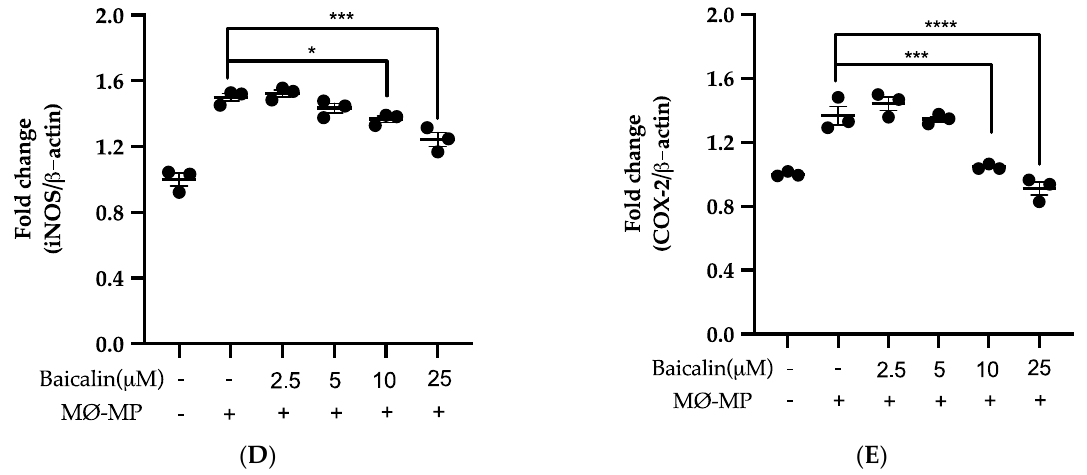
Figure 2. Effect of baicalin on nitric oxide (NO) production, iNOS, COX-2 protein expression in RAW 264.7 cell. ( A ) RAW264.7 cell was incubated with MØ-MP and a various dose of baicalin for 24 h, followed by MTT solution for 4 h. The absorbance of purple formazan was taken at 540 nm. ( B ) RAW264.7 cell was treated with or without MØ-MP and various doses of baicalin for 24 h. The NO release by activated RAW264.7 in the supernatant media was mixed with an equal volume of Griess reagent and absorbance of resultant color was taken at 540 nm. ( C ) The cell lysate of RAW264.7 treated with or without MØ-MP and various doses of baicalin for 24 h were subjected to SDS-PAGE for the detection of iNOS and COX-2 protein expression by Western blot. β -actin was used for normalization. ( D ) Quantitative data of iNOS fold change. ( E ) Quantitative data of COX-2-fold change. Each value is the mean ± SE of three to four independent experiments and each independent experiment contains five replicates. * p < 0.05, *** p < 0.001, **** p < 0.0001 vs. control ( MØ-MP alone). The analysis was performed using one-way ANOVA followed by Dunnett multiple comparison test.